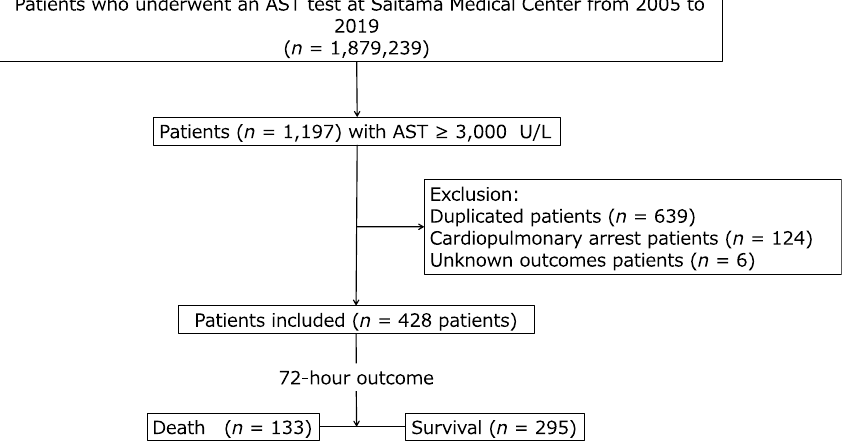
Figure 1. Flow diagram of patient selection. Among the 1,879,239 patients who underwent testing at our medical centre’s clinical laboratory, 1197 had extremely high outlier values of serum aspartate aminotransferase (AST; ≥ 3000 U/L) during a 15-year period, from 2005 to 2019. After applying the exclusion criteria, 124 patients with cardiopulmonary arrest upon arrival, 6 with unknown outcomes, and 639 metachronous duplicates of the same patient were excluded. Finally, 428 patients, including 133 non-survivors (died within 72 h) and 295 survivors (survived beyond 72 h) were enrolled in this